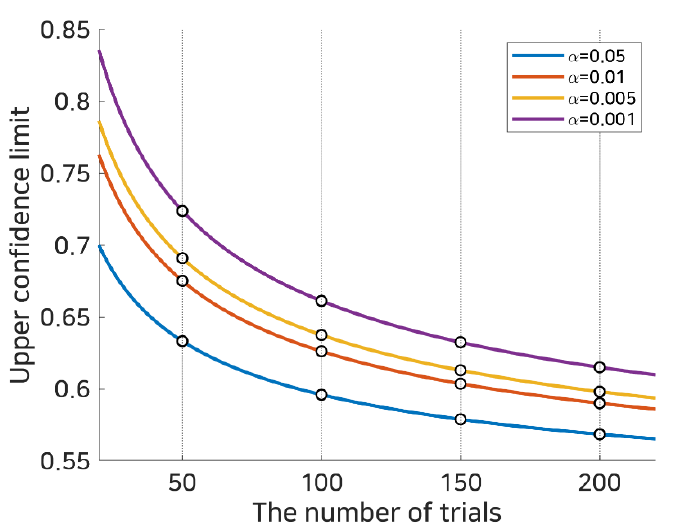
Figure 2. Random statistical probability. This represents the subject selection criteria using random statistical probability based upon the number of trials in binary classification. Each bold line denotes the statistical random probability calculated as in Equation (2) at statistical significance α , and the white dots on the dotted line indicate statistical random probabilities at 50, 100, 150, and 200 trials.